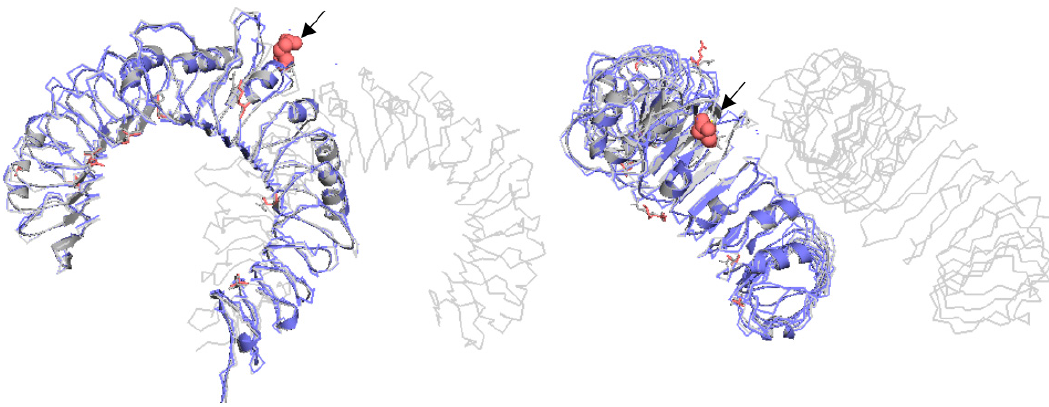
Figure 6. Predicted three-dimensional structures of homodimer of TLR2 representing the H326Q (arrows) variant. Blue : AB breed H326Q carrying individual, dark grey : one individual of HOL breed.